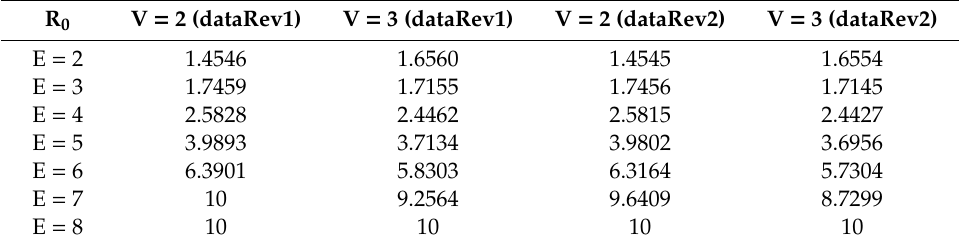
Table 2. Estimation of the basic reproduction number for 2019-nCoV in Wuhan, China. R 0 V = 2 (dataRev1) V = 3 (dataRev1) V = 2 (dataRev2) V = 3 (dataRev2) E = 2 1.4546